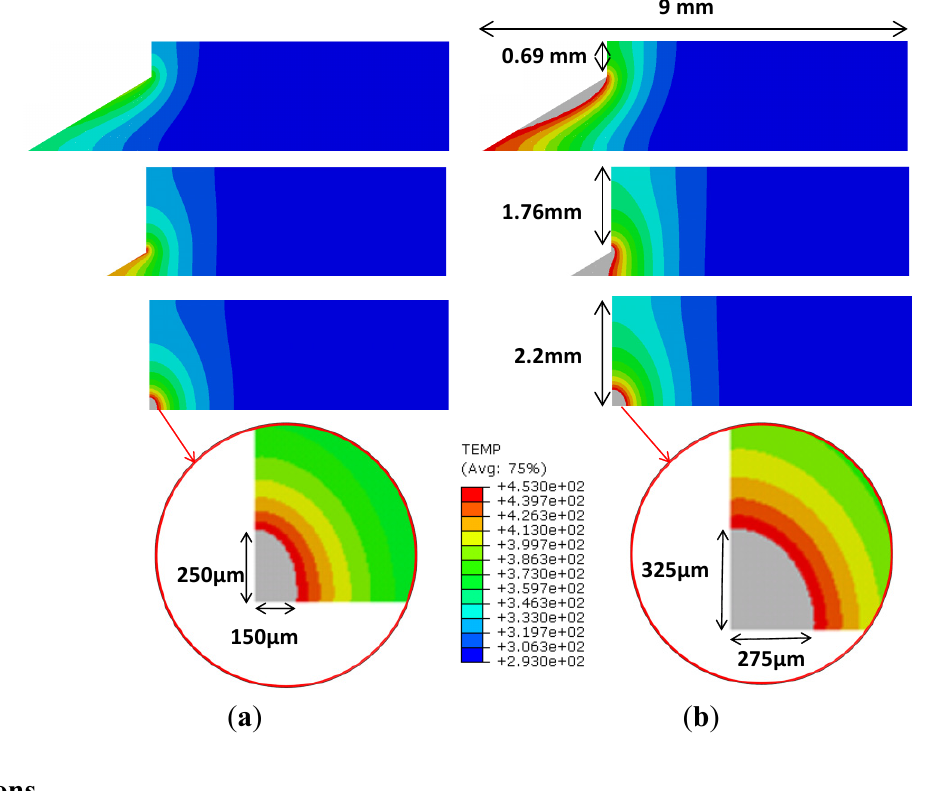
Figure 6. Predicted temperature (K) for tests developed at cutting speed 50 m/min and feed 0.1 mm/rev (grey zone represents temperature higher than 180 °C, 453 K): ( a ) fresh tool; ( b ) worn